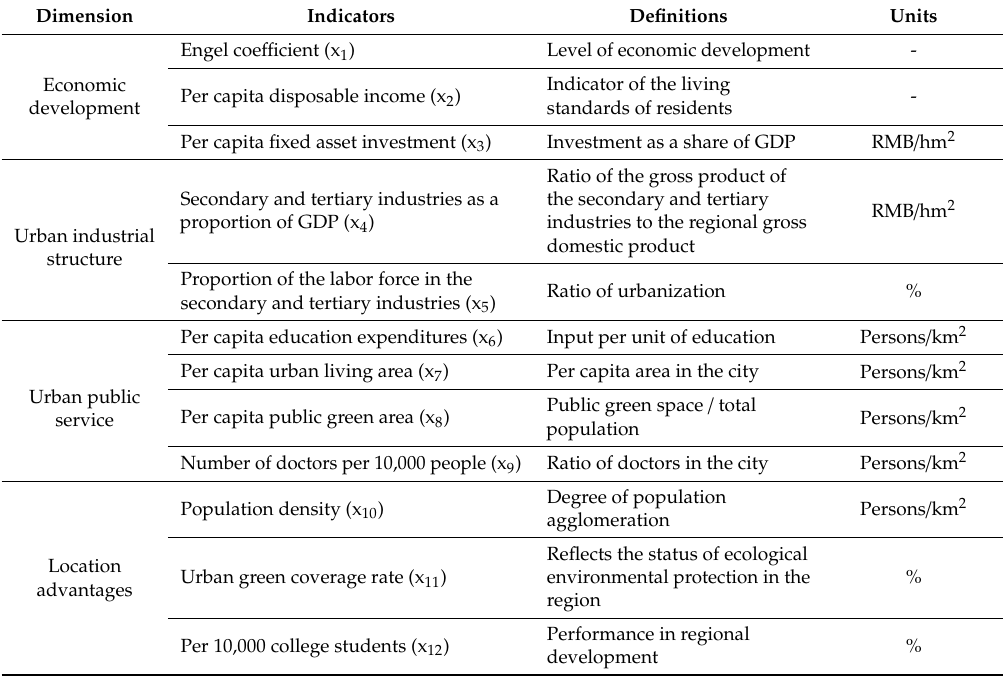
Table 3. Variables for assessing the influencing factors of urban sustainability.